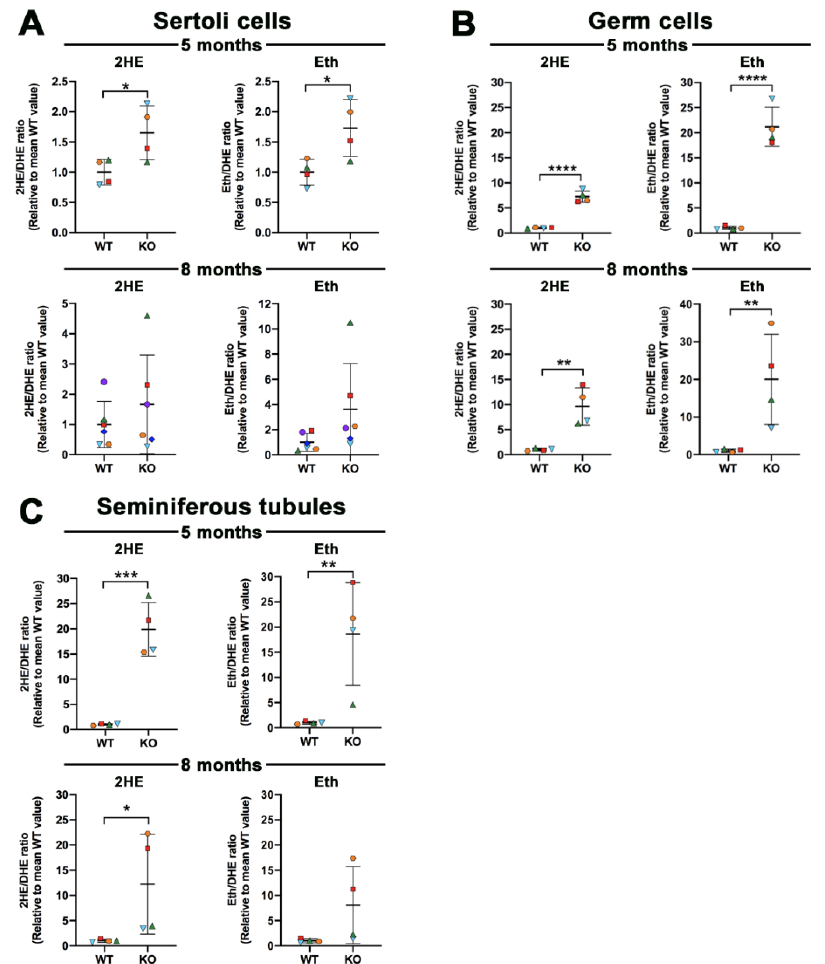
Figure 5. ROS levels in Sertoli cells ( A ), testicular germ cells ( B ) and seminiferous tubules (C) from Arsa KO mice and age-matched WT mice, 5 months and 8 months of age. Cells and minced tissues were incubated with DHE. Superoxide generated intracellularly converted DHE to 2HE, whereas other ROS and oxidants changed DHE to Eth. Changes of 2HE/DHE and Eth/DHE in cells and tissues from Arsa KO mice were expressed as fold increases from corresponding values from age- matched WT mice. Results on Sertoli cells from 8-month-old WT and Arsa KO mice were from 6 replicate experiments, whereas those on Sertoli cells from 5-month-old WT and Arsa KO mice, and testicular germ cells and seminiferous tubules from WT and KO mice of both ages were each from 4 replicate experiments. *, **, ***, **** denote p < 0.05, 0.01, 001 and 0.0001, respectively.